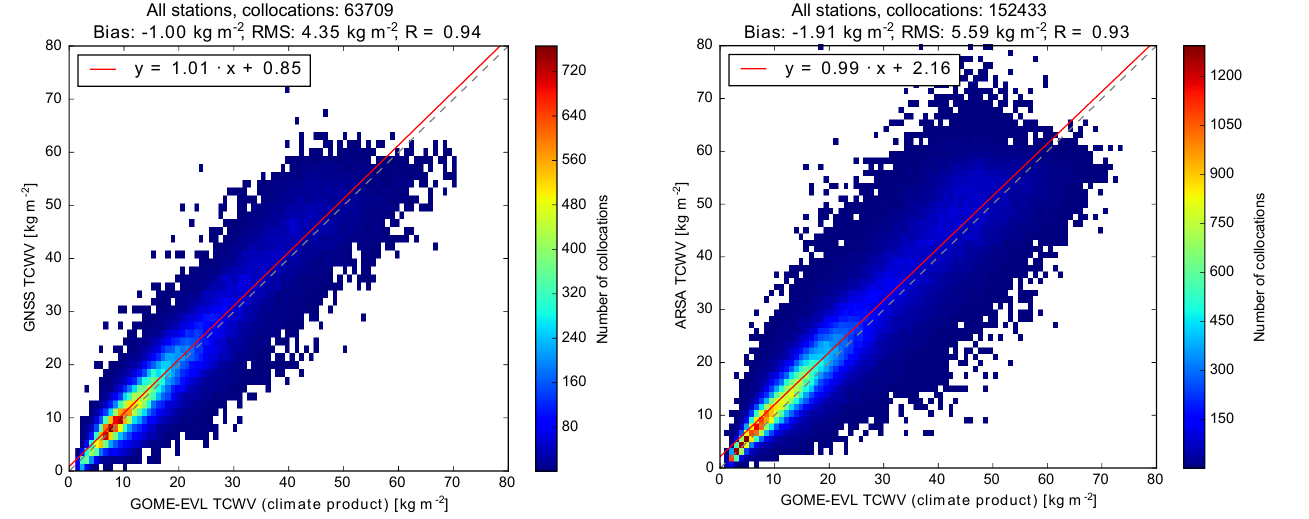
Figure 12. Scatter plot of TCWV monthly means of all available ARSA stations and the climate product. Figure from Danielczok and Schröder